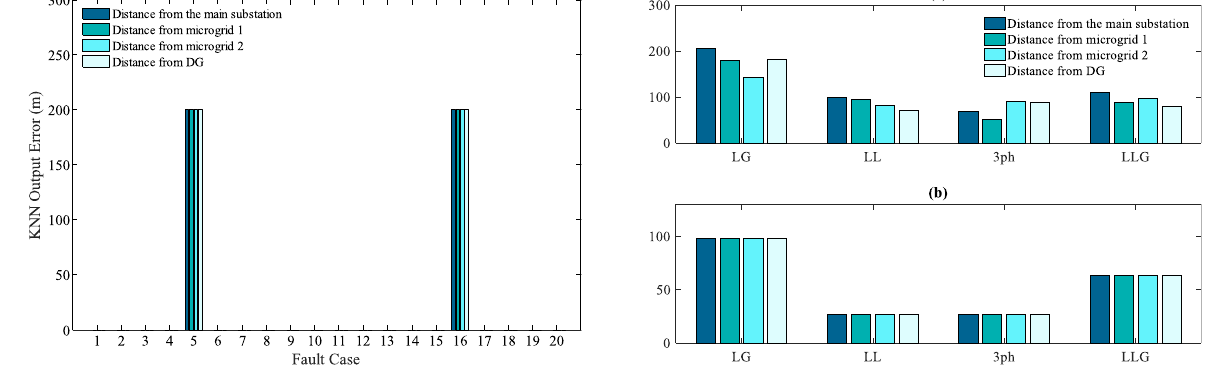
Fig. 9 Output RMSE values for different fault types for 424 test cases. a for ANN outputs b for KNN